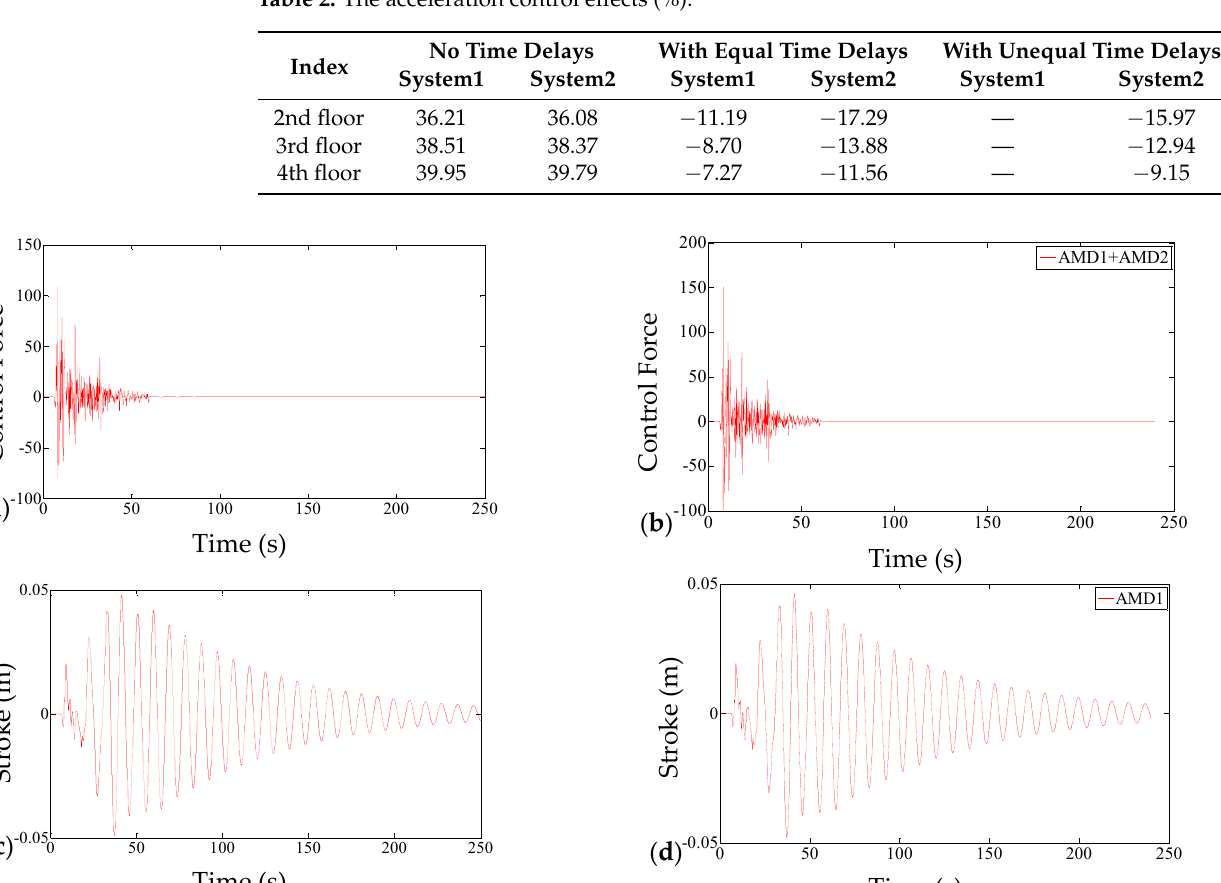
Table 2. The acceleration control effects (%).